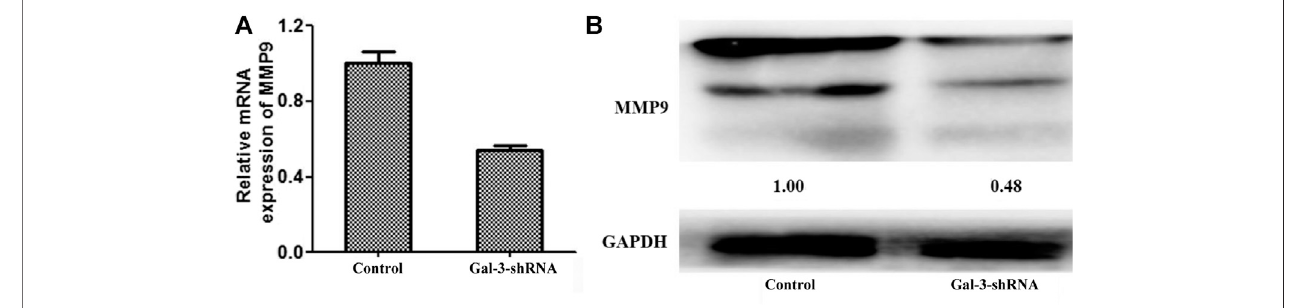
FIGURE4| Down-regulationofMMP9ismediatedbyGal-3knockdown.ThemRNAandproteinlevelsofMMP9weredetectedbyqRT-PCR (A) andWesternblot (B) in ICC cells transfected with